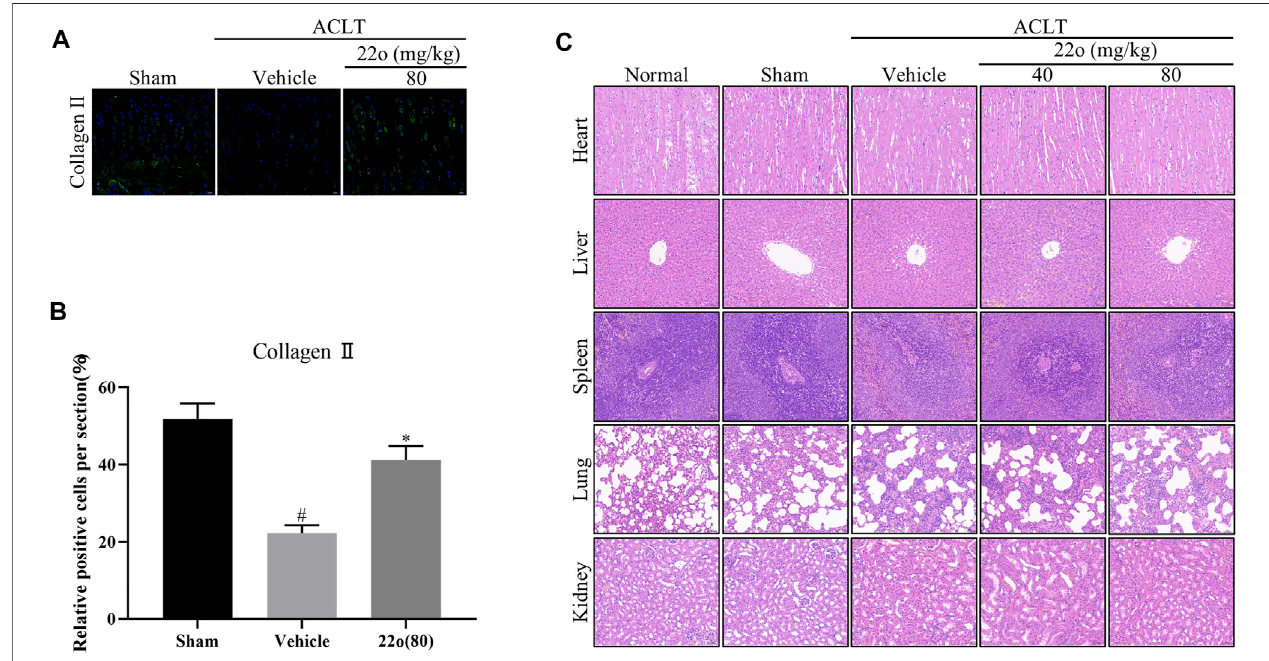
FIGURE6 | Compound 22oalleviatesthe progression ofOA. (A) Representativeimagesofimmuno fl uorescent staining and (B) quantitative analysis ofCOL2A1 in the cartilage samples from three groups 6 weeks after treatment (scale bars, 20 μ m, n = 6). (C) Representative images ofHE staining ofrat heart, liver, kidney, lung, and spleen from fi ve groups 6 weeks after treatment (scale bars, 50 μ m). # p < 0.05 vs. sham group; * p < 0.05 vs. vehicle